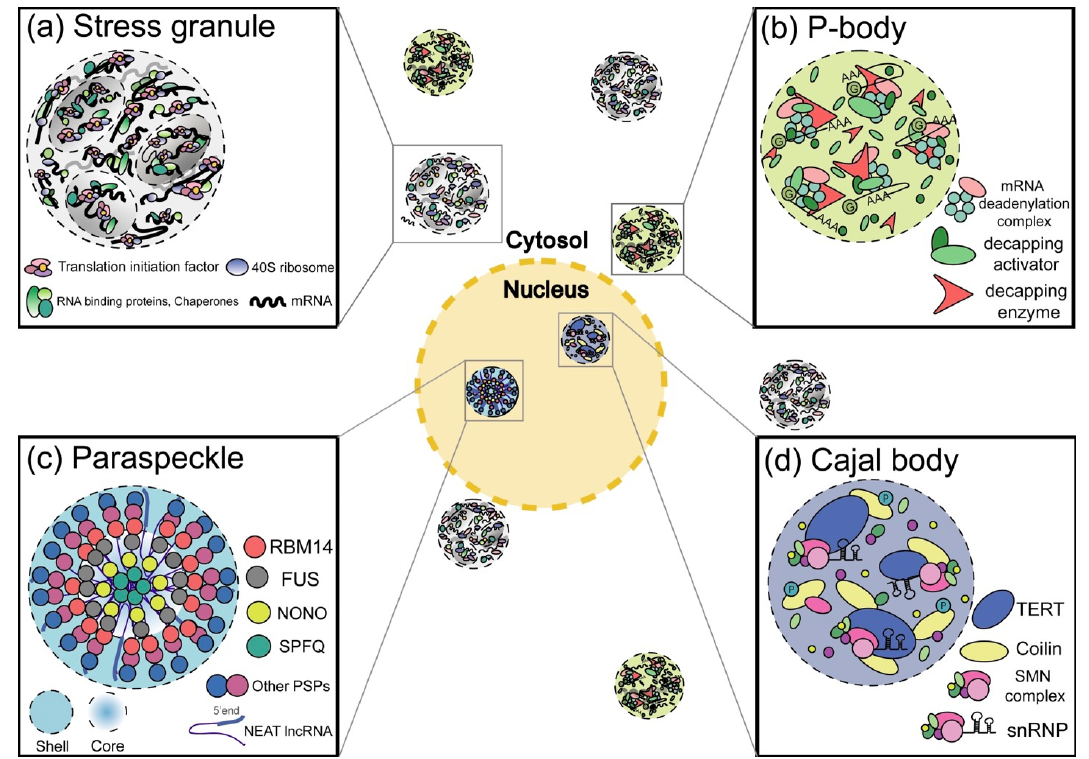
Figure 1. Cellular ribonucleoprotein (RNP) granules. ( a , b ) Schematic structural representation of cytoplasmic RNP granules. ( a ) Stress granules (SGs) containing untranslated mRNA, ribosomes, translational initiation factors, and RBPs. ( b ) P-bodies containing untranslated mRNAs and RBPs. (c and d) Schematic structure of nuclear RNP granules. ( c ) Paraspeckles containing lncRNA NEAT1 and nuclear-localized RBPs. ( d ) Cajal bodies containing snRNPs, snoRNPs, and nuclear RNPs.